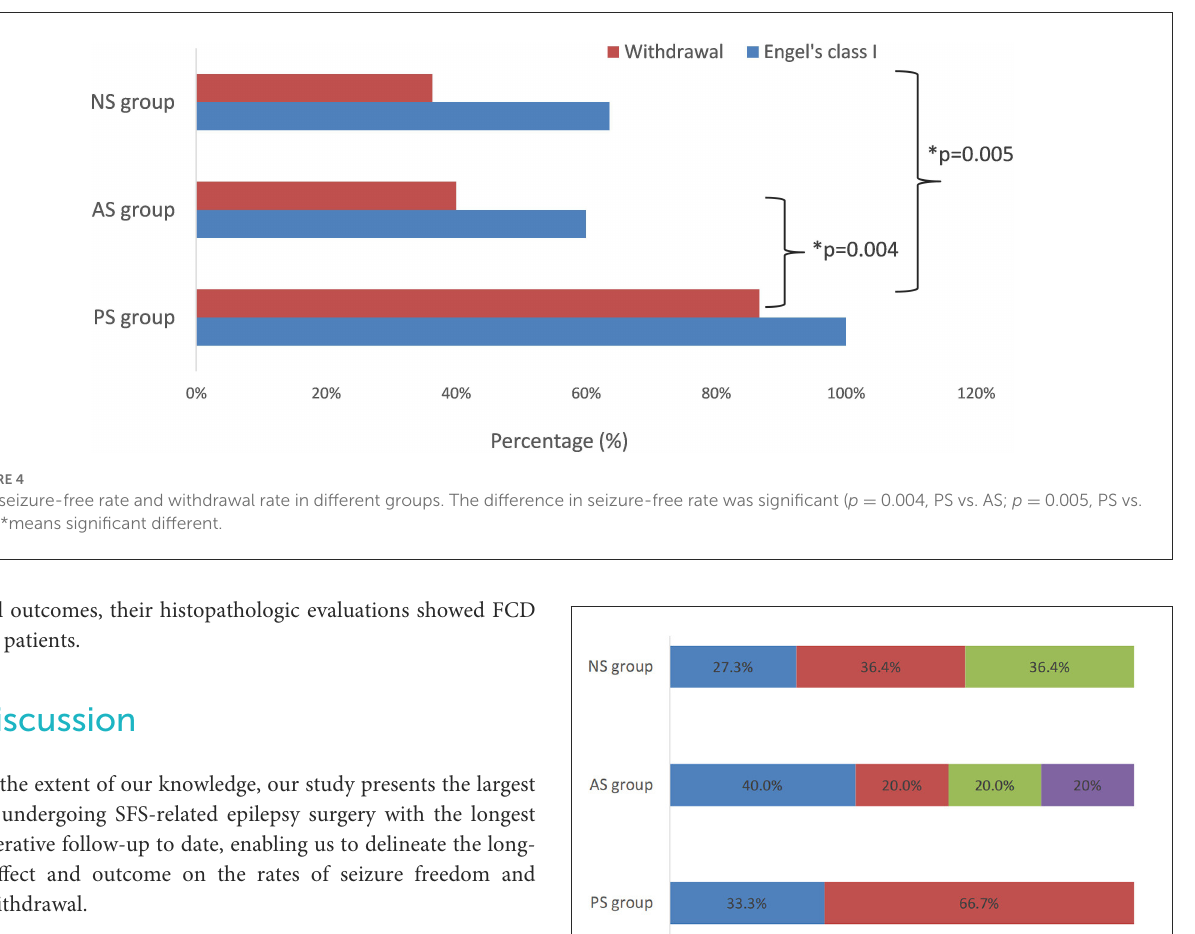
FIGURE5 The pathological feature and the percentage of FCD type in different